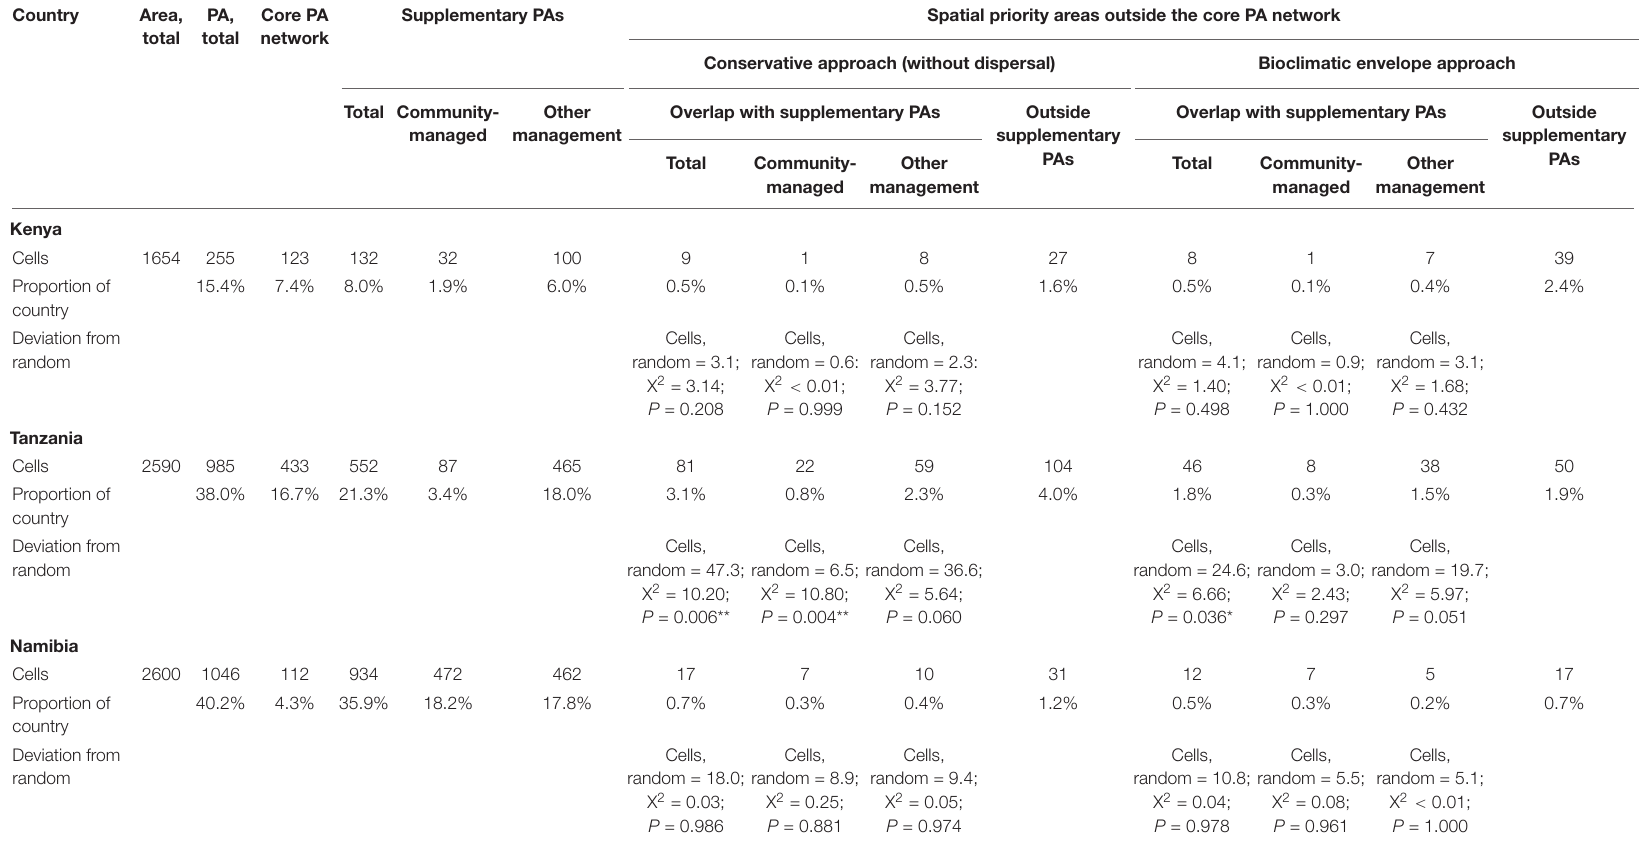
TABLE 1 | Protected area coverage according to WDPA (UNEP-WCMC 2012) and spatial priority areas for antelope conservation in three African countries (* P < 0.05; ** P < 0.01).